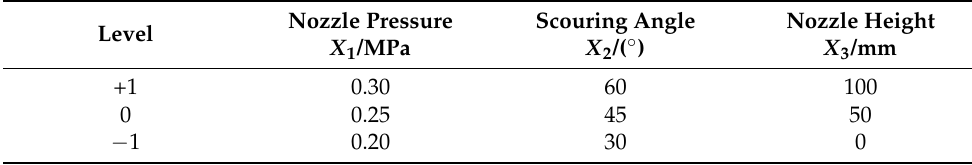
Table 9. Factors and levels of Box–Behnken central combination design tests.